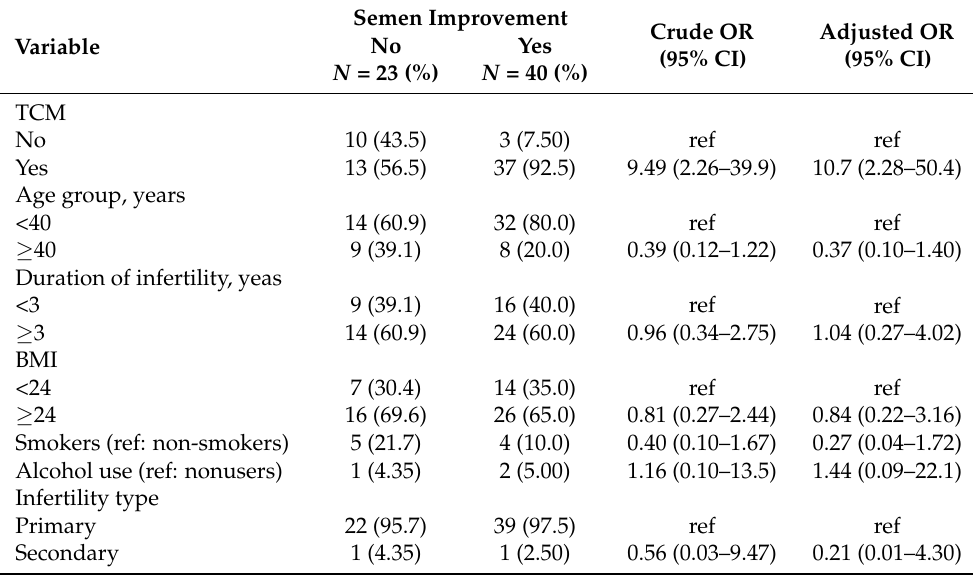
Table 2. Odds ratios and 95% confidence intervals for semen improvement.